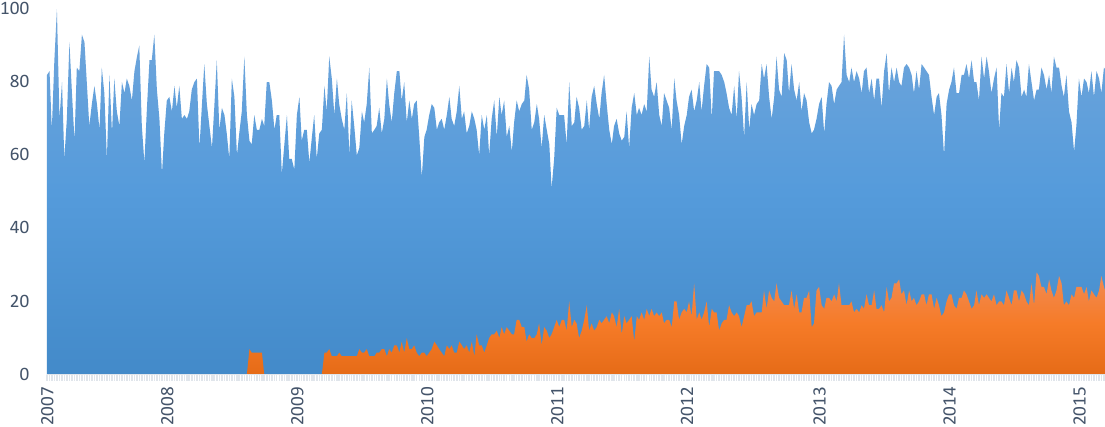
Figure 1. Interest over time in “low back pain” (blue chart) and “medical app” (orange chart) terms. Results obtained through Google Trends. The values, expressed in percentages, reflect the amount of searches that have been done for each term, relative to the total number of searches done on Google over